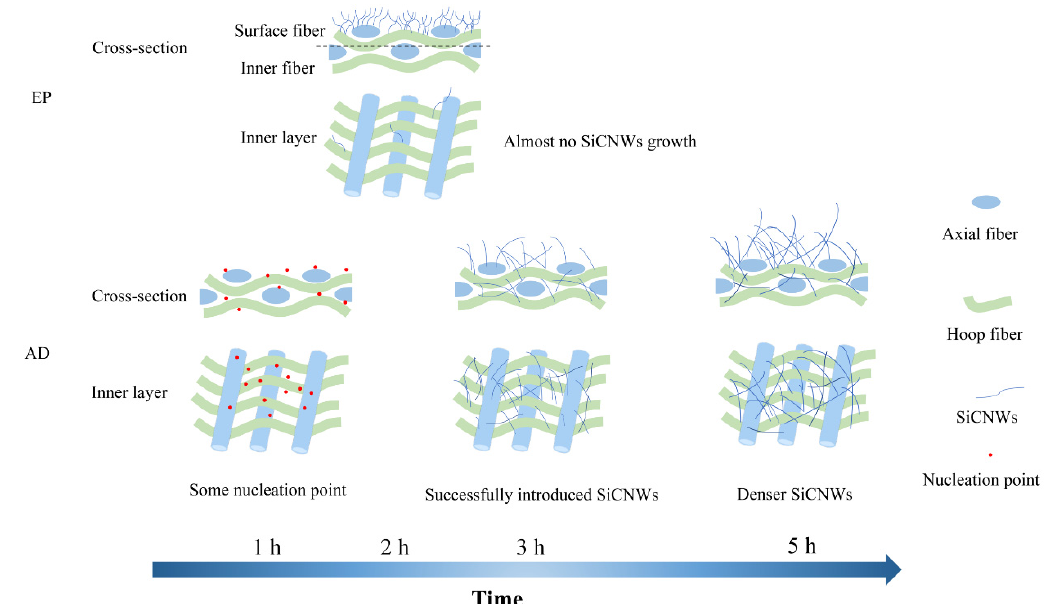
Figure 6. Schematic diagram of the growth mechanism of SiCNWs by EP and AD methods.